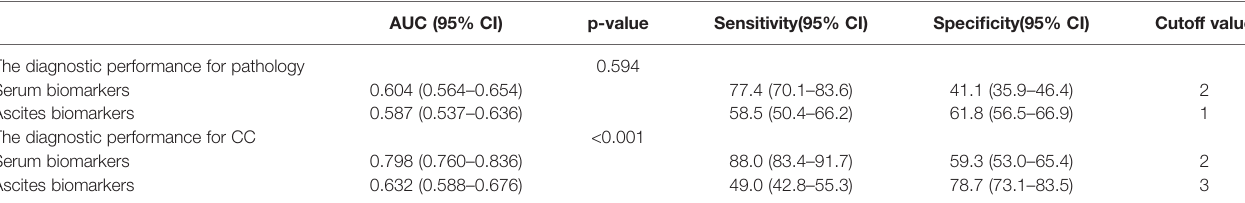
TABLE 2 | The diagnostic performance of serum and ascites biomarkers in the prediction of pathology and completeness of cytoreduction (CC) in pseudomyxoma peritonei (PMP)